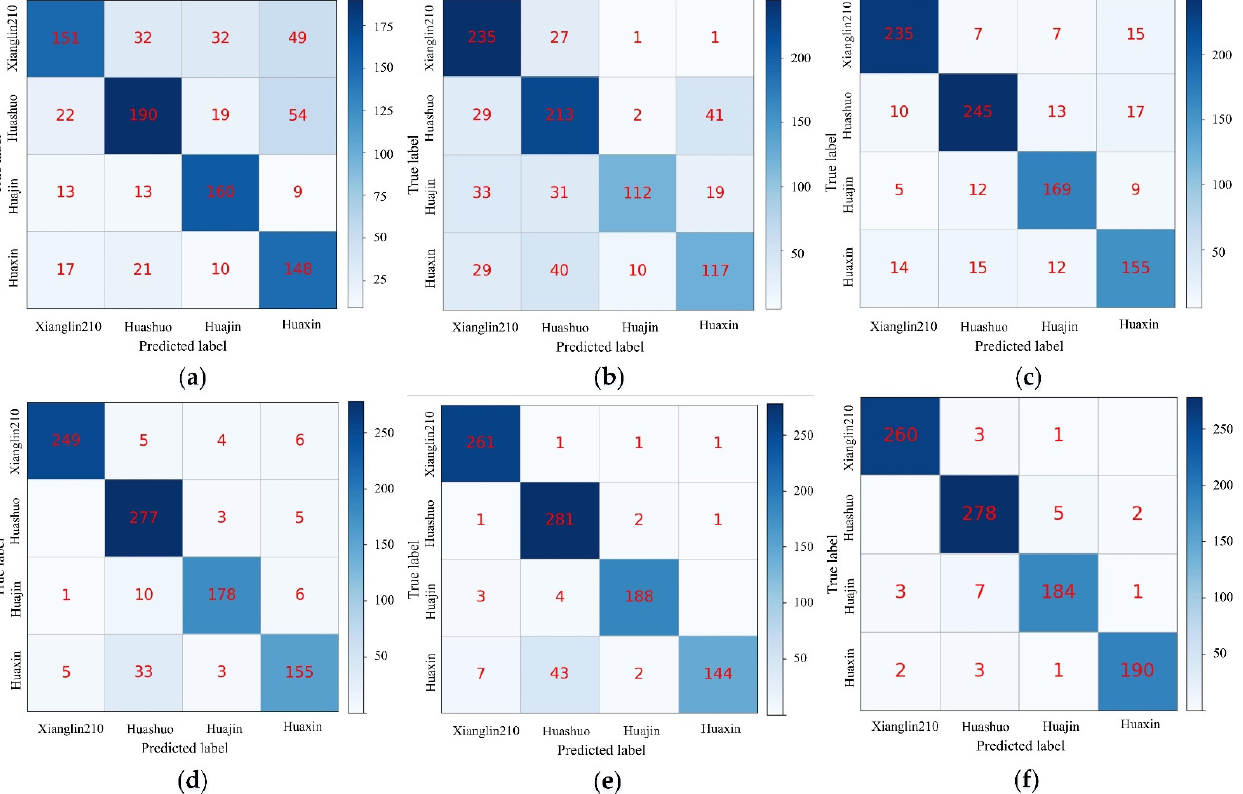
Table 3. Quantitative evaluation results of different model.